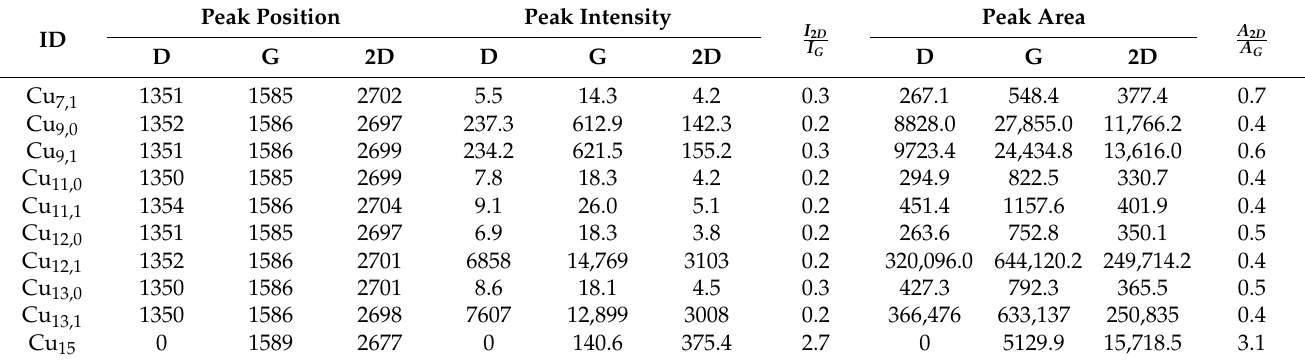
Table 4. Peak positions, intensities, and the number of layers from the Raman